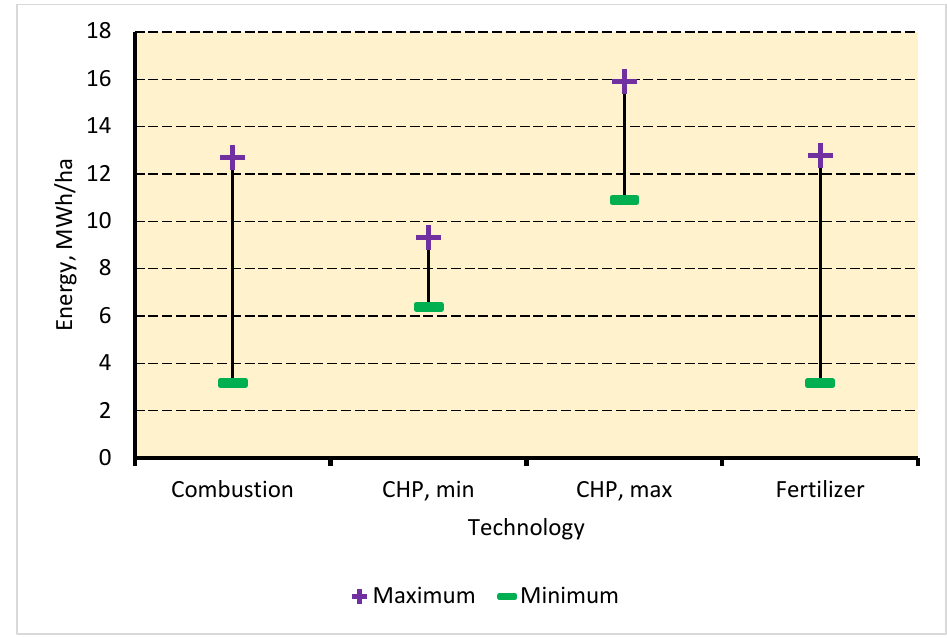
Figure 8. Energy produced per sorghum silage grown on one hectare.